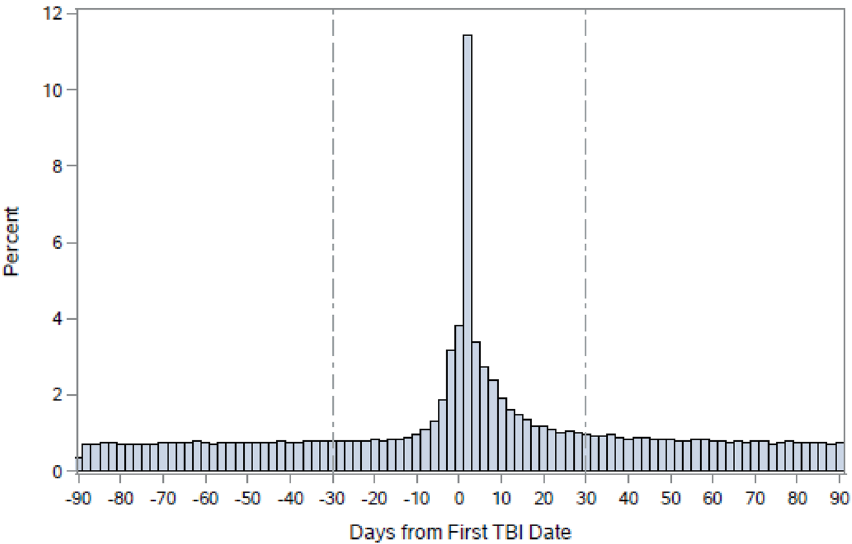
Figure 1. A number of hospital visits surrounding the TBI index date. Reprinted from Mollayeva, T. et al. 6 . The figure was originally published under a CC BY license (Creative Commons Attribution 4.0 International